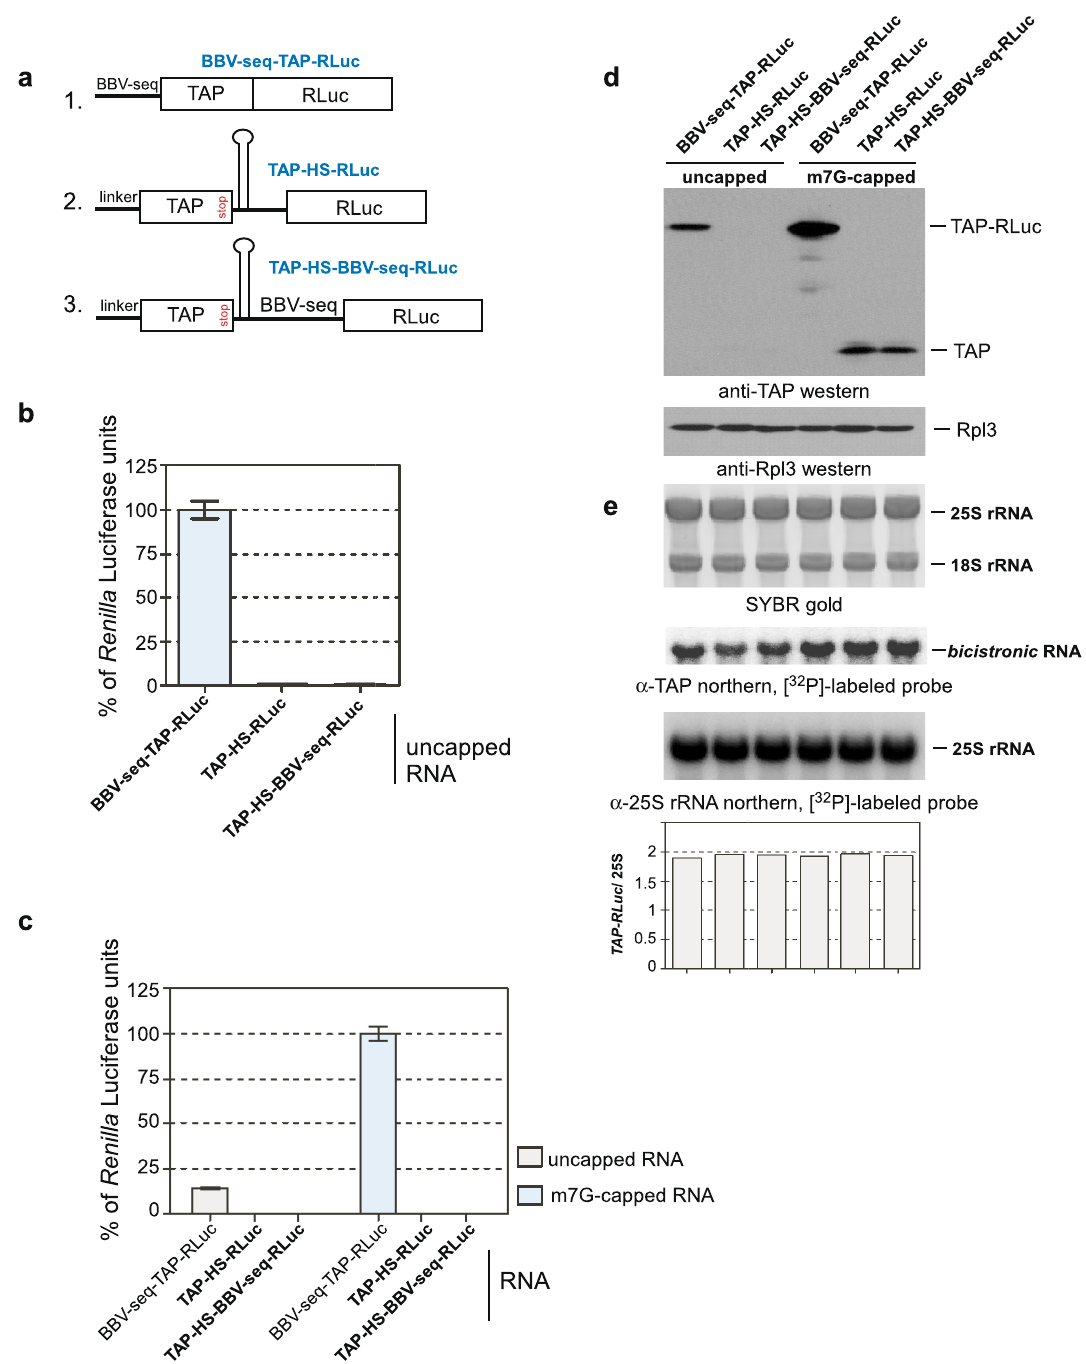
Figure 5. BBV-seq fails to initiate translation when placed upstream of ORF2 ( RLuc ) in a bicistronic construct. ( a ) Schematic representation of the constructs. In bicistronic constructs, ORF1 ( TAP ) and ORF2 ( RLuc ) are separated by the hairpin-spacer-BBV-seq (HS-BBV-seq, construct 3) or hairpin-spacer (HS, construct 2). In monocistronic construct 1, TAP is fused with RLuc and placed under the BBV-seq 5 ′ -UTR. ( b , c ) RNA generated from constructs shown in ( a ) was in vitro m7G-capped or remained unmodified and then translated in cell-free reactions. Reaction products were analyzed by a Renilla luciferase assay. Data are presented as % of Renilla luciferase units in reactions with uncapped BBV-seq-TAP-RLuc mRNA ( b ) or m7G-capped BBV- seq-TAP-RLuc mRNA ( c ). ( d , e ) Proteins and RNA extracted from the luciferase reactions shown in ( b , c ) were analyzed by western blotting with anti-TAP and anti-Rpl3 antibodies ( d ) and northern hybridizations with the indicated probes ( e ). SYBR Gold staining of RNA prior to transfer is shown in ( e ). TAP-RLuc /25S rRNA ratios of hybridization signals in each lane are